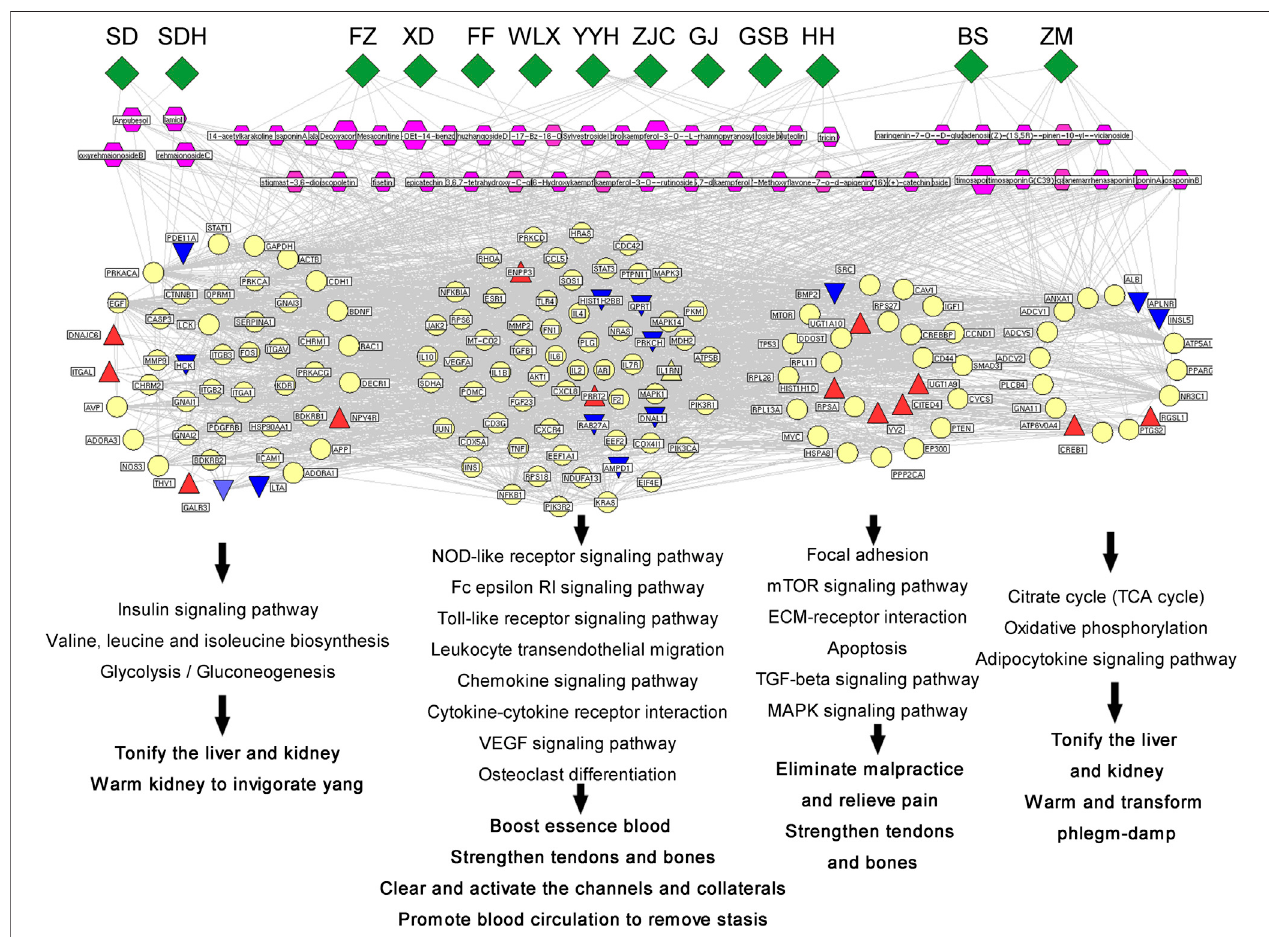
FIGURE 7 | Network of “ Herbal Medicines of WBT-Key Active Components-Core Modules-Traditional ef fi cacy ” was visualized using NaviGator v3.0.